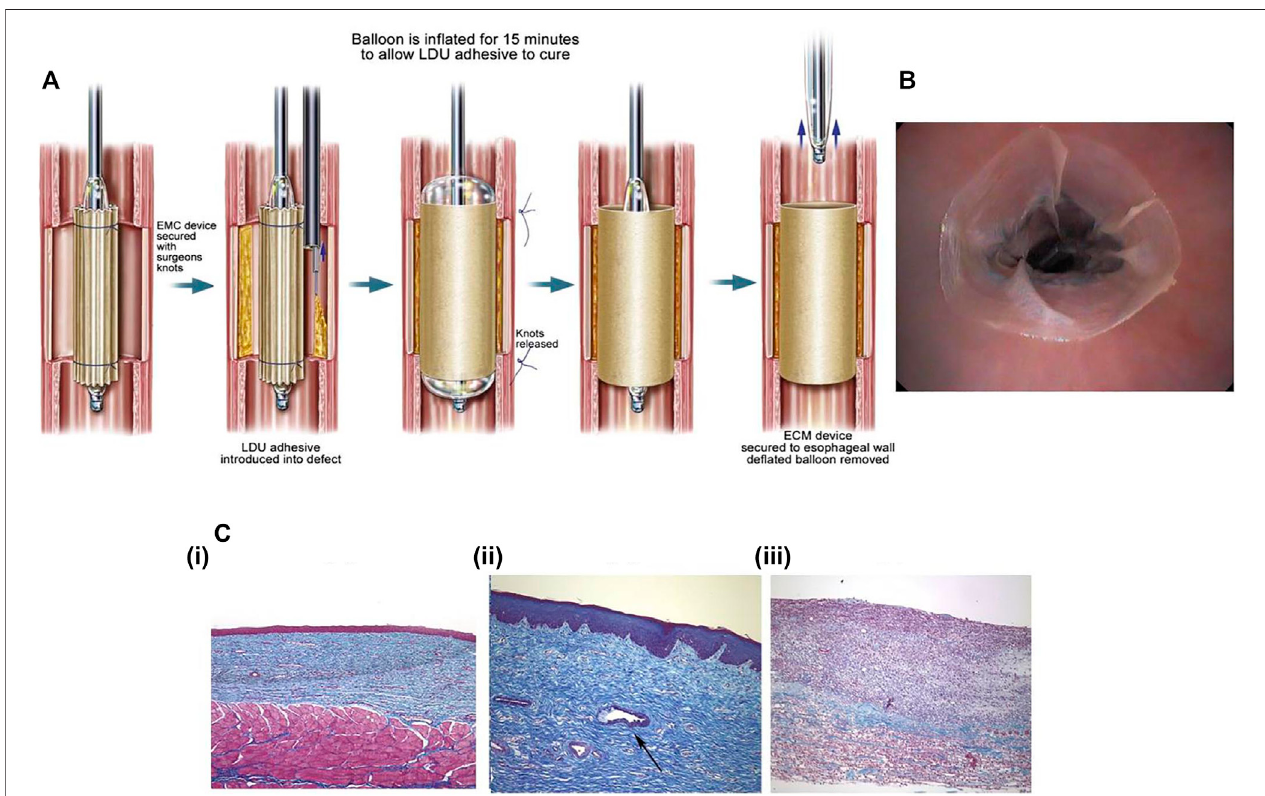
FIGURE 9 | The ECM stents that have been reported to prevent esophageal stricture. (A) The schematic diagram of deployment of ECM stent with the internal supporting of balloons. (B) Endoscopic image of the ECM stent applied to post-EMR esophageal defect. (C) The histological assessment of the esophagus after 2 months of the deployment of ECM stents. [C (i)] The esophageal mucosa treated by ECM stents has intact squamous epithelium. [C (ii)] The gland formation in the submucosaoftheesophagus treatedwithECMstents. [C (iii)] Thesigni fi cant fi brosis withextensivein fi ltration ofin fl ammatory cells intheesophagealsubmucosa in the control group. Reproduced from Nieponice et al. (2009). Copyright (2009), with permission from Elsevier.